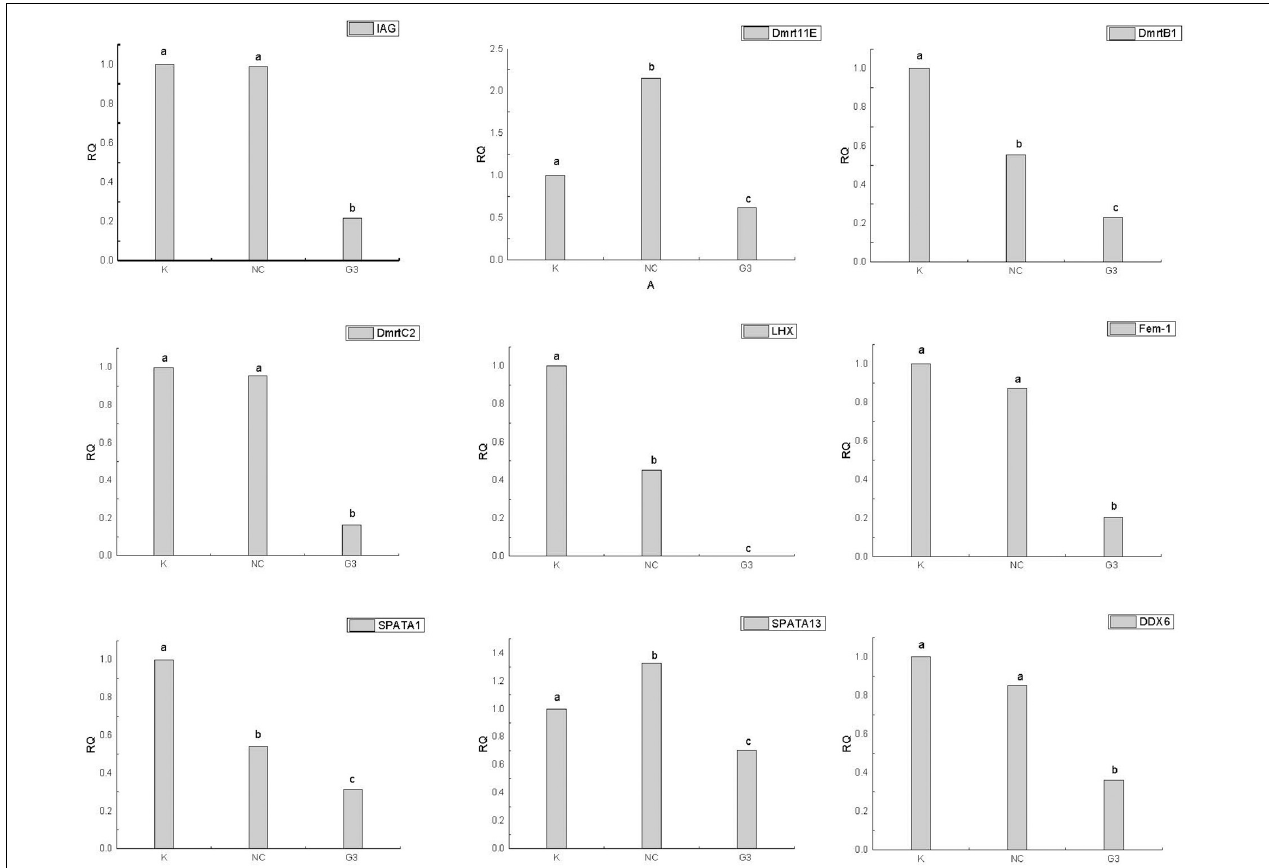
FIGURE 8 | Expression of other sex-related genes after PtDMY knockdown. Means with different letters are significantly different ( P < 0.05).